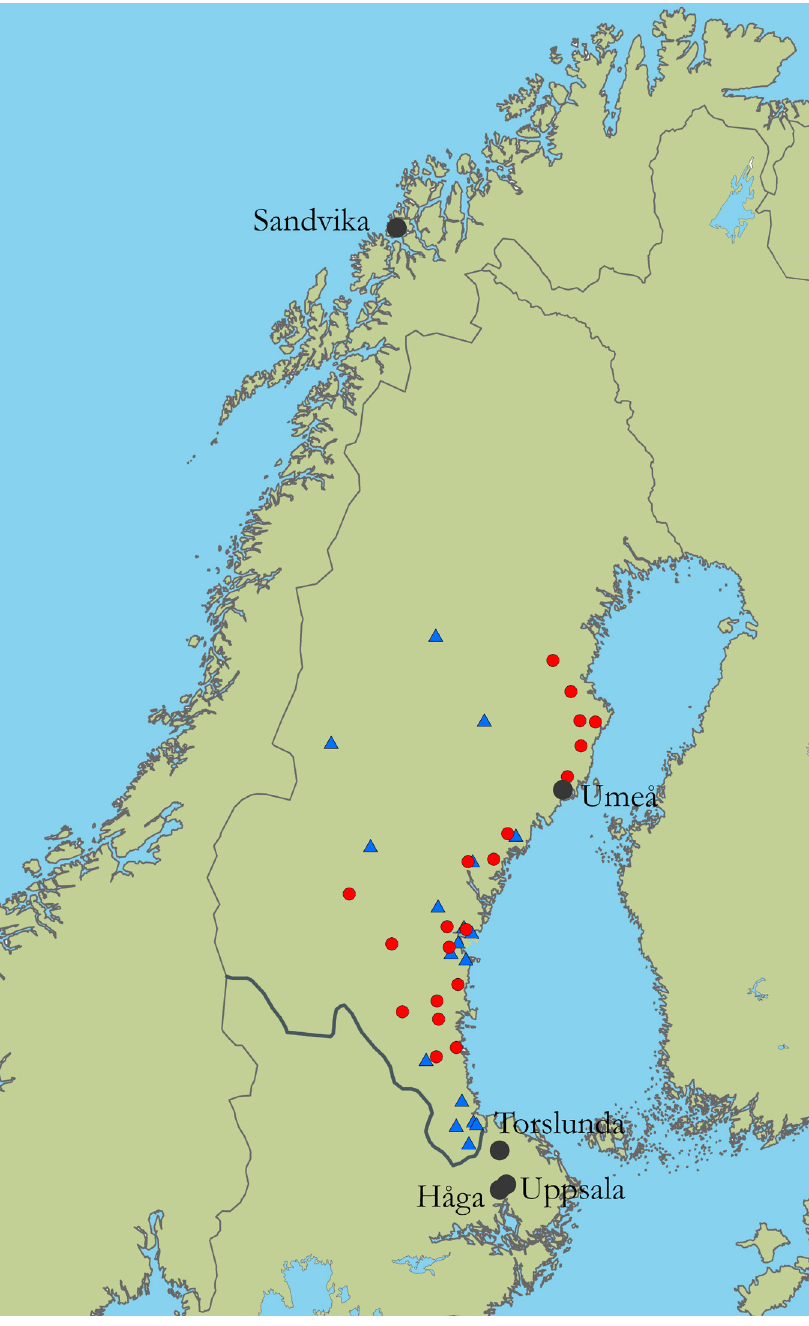
Figure 5: Map showing the location of sites mentioned in the article and the distribution of known bronze artefacts from the northern part of Sweden. Red dots represent bronze objects from the Early Bronze Age. Blue triangles represent bronze objects from the Late Bronze Age. Based on information from Larsson (2017, p. 4, 32). Map by